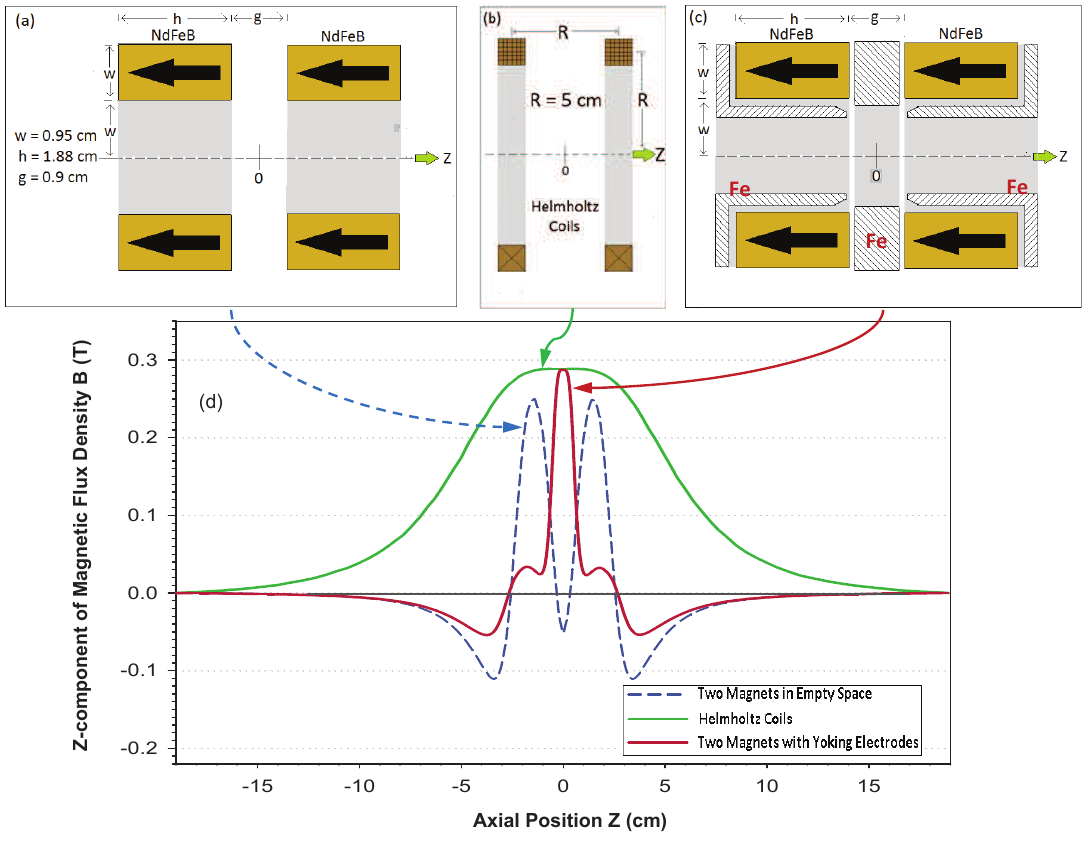
Figure 2. Comparison of magnetic field sources. ( a ) Two annular NdFeB magnets with their axial magnetization aligned coaxially; ( b ) Helmholtz coils of radius R = 5 cm (the scale is different), each wound with 1650 turns of wire carrying 10 A of current to produce the same central field as a unitary Penning trap; ( c ) two annular NdFeB magnets yoked by soft iron electrodes to form a unitary Penning trap; and ( d ) axial component of the magnetic field for these three sources as a function of axial